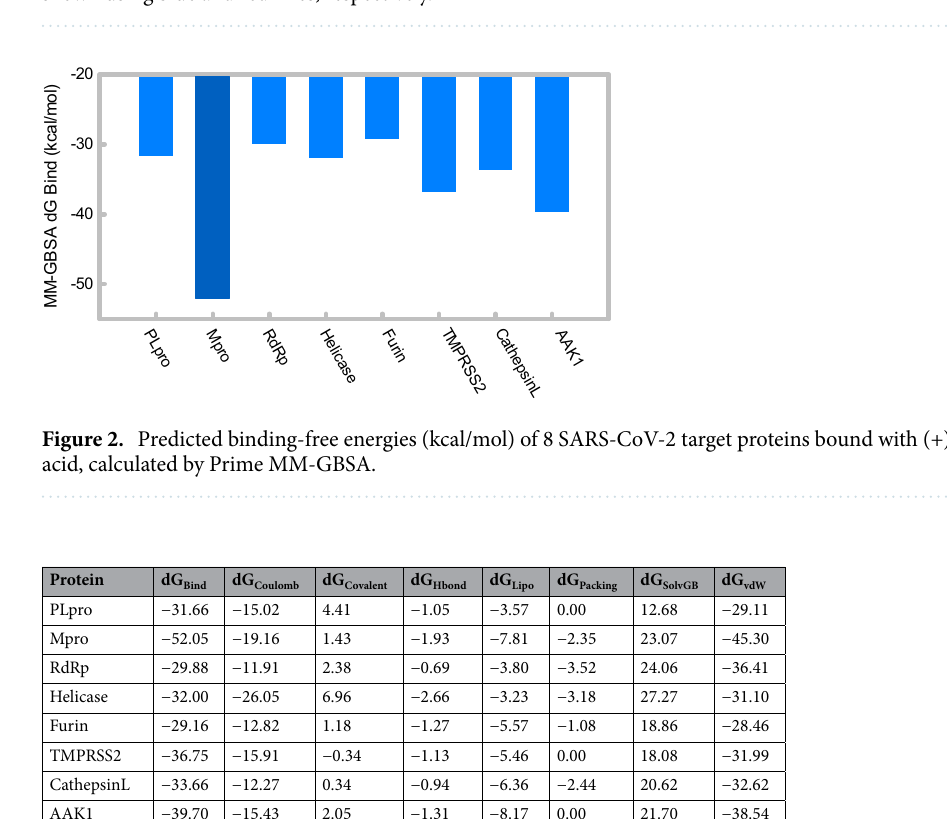
Figure 1. The anti-SARS-CoV-2 efficacy of (+)-usnic acid and controls; ( a ) The structure of (+)-usnic acid on the left and dose response curve of (+)-usnic acid against SARS-CoV-2 on the right; ( b ) The dose response curve of controls (chloroquine, lopinavir and remdesivir); the inhibition of infection and cell number to mock is shown using blue and red lines, respectively.